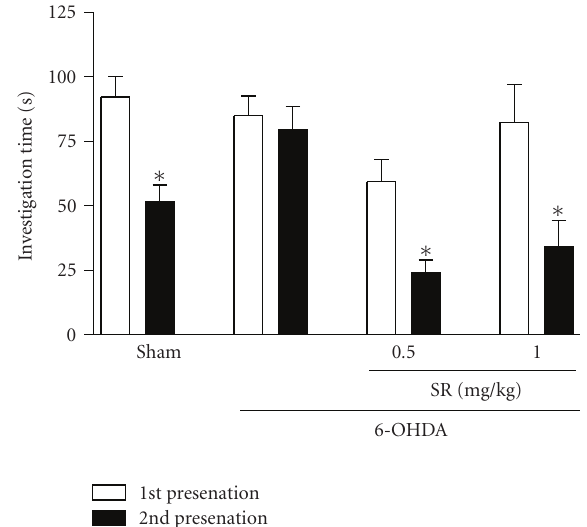
Figure 2: E ff ects of acute administration of SR141716A (0.5 and 1mg/kg) i.p. 30 minutes before social recognition test on 6-OHDA- treated rats. Results are expressed as mean investigation time ± SEM in comparison to sham controls. Statistical analysis was performed by two-way repeated-measure ANOVA followed by Bonferroni’s post hoc test. ∗ P ≤ .05 compared to the first juvenile presentation ( n = 8 per